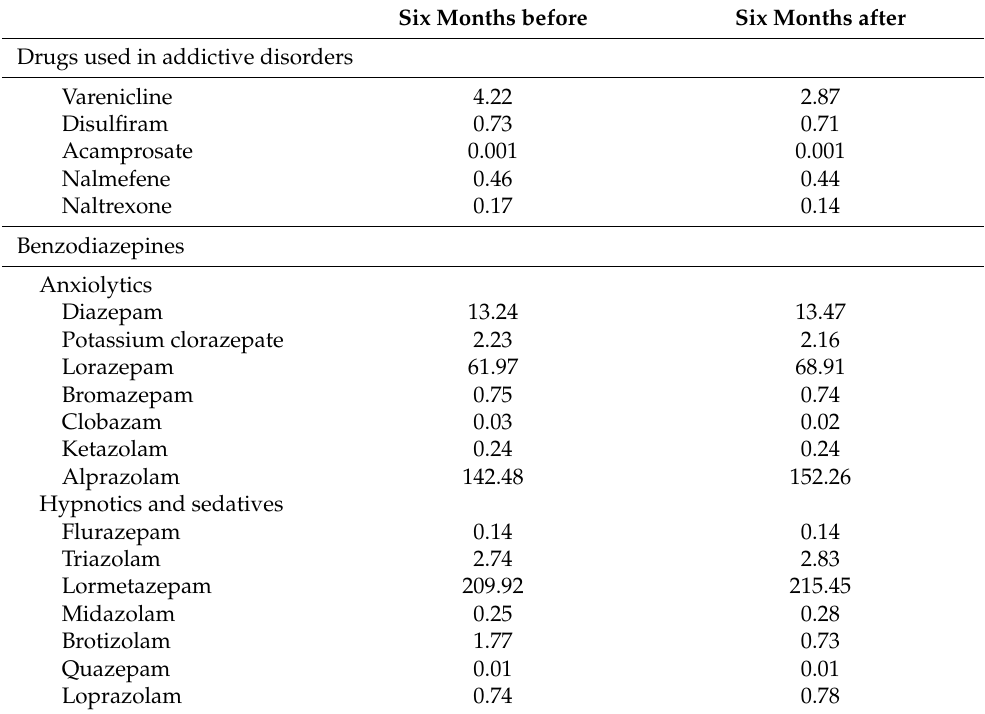
Table 3. Number of DHDs six months before and six months after lockdown. Six Months